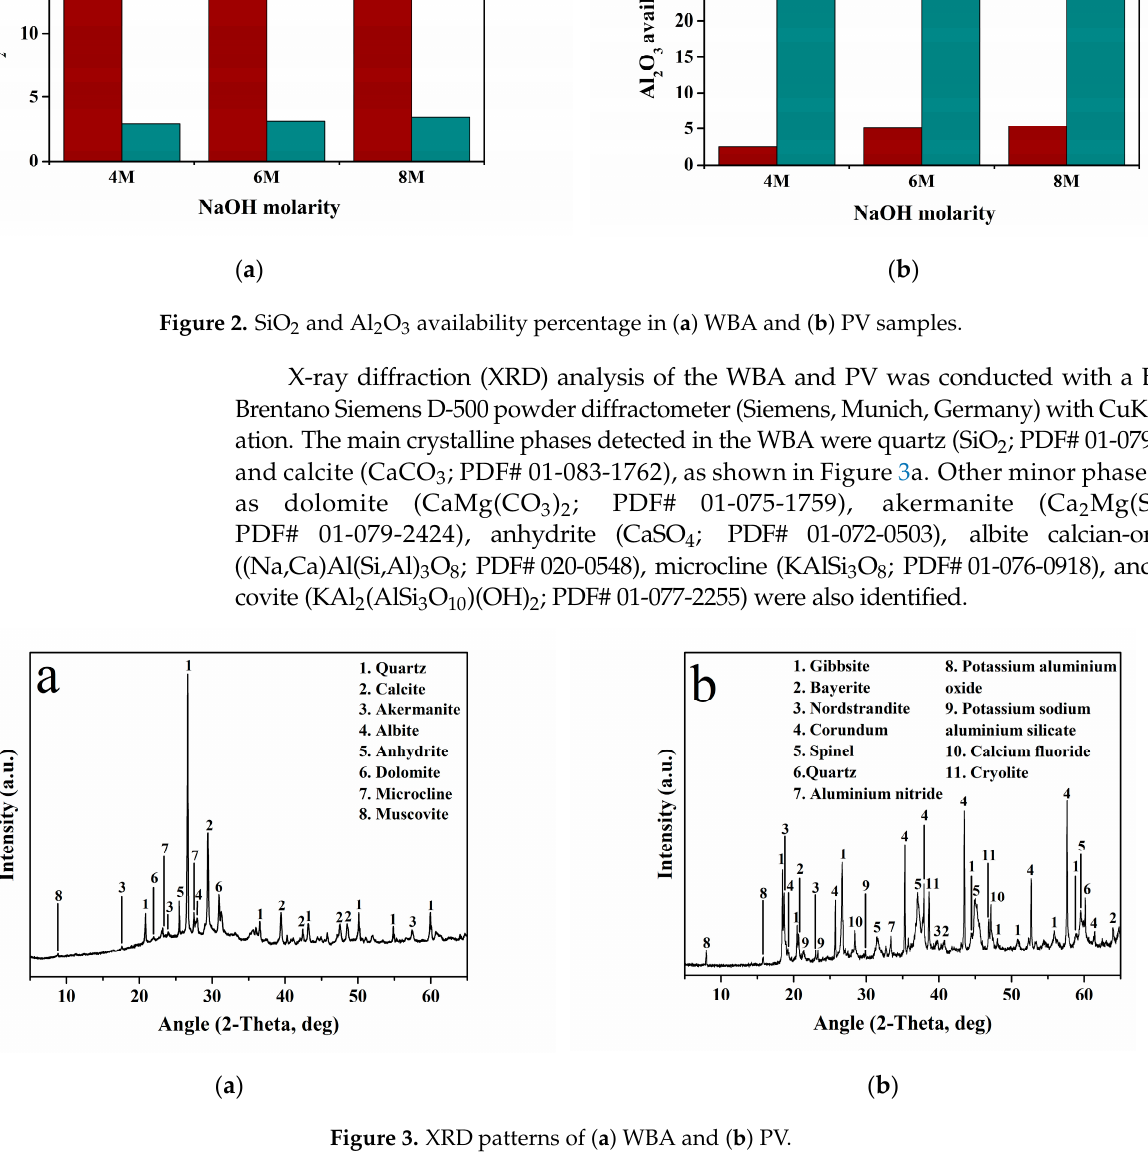
Figure 3. XRD patterns of ( a ) WBA and ( b ) PV.